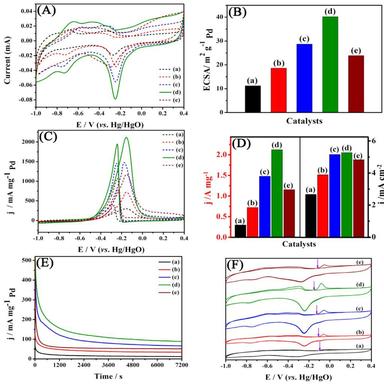
(A) CVs of the catalysts in N2-saturated 1.0 M KOH solution at scan rate of 50 mV s−1. (B) Histograms of ECSA for the catalysts. (C) CVs of the catalysts in 1.0 M KOH and 1.0 M C2H5OH solution at scan rate of 50 mV s−1. (D) Histograms of mass activity and specific activity for the catalysts. (E) Chronoamperometry curves for the catalysts in 1.0 M KOH and 1.0 M C2H5OH solution at a constant potential of −0.1 V. (F) CO stripping voltammograms of the catalysts in 1.0 M KOH solution at scan rate of 50 mV s−1. T